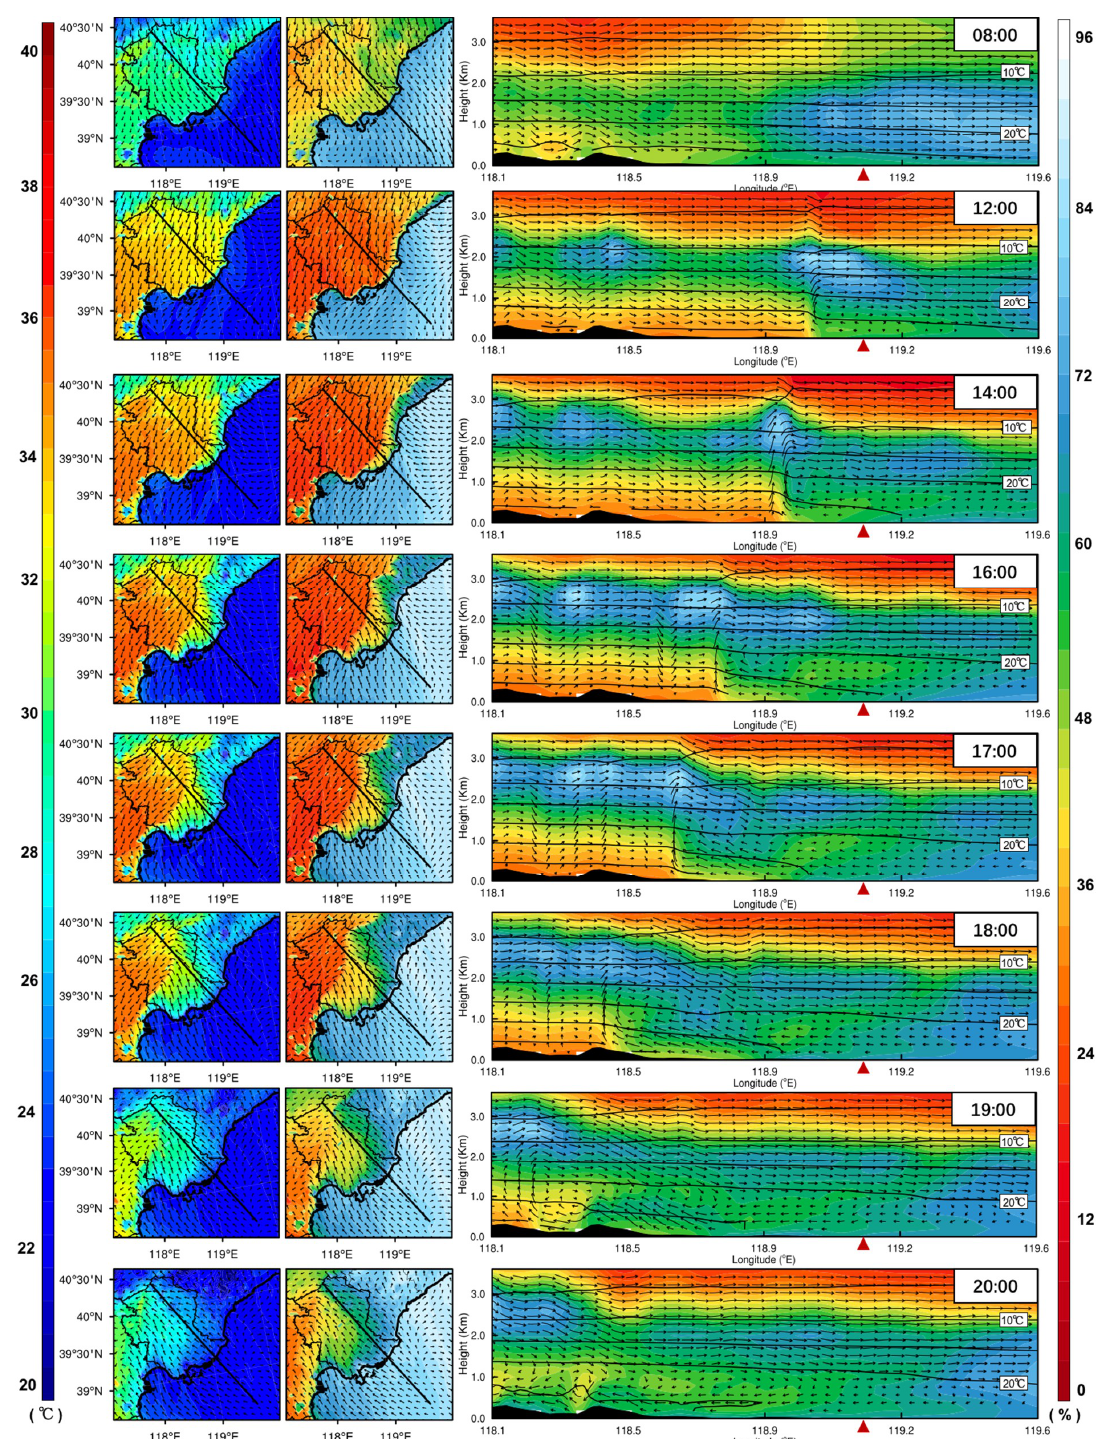
Figure 4. The simulated horizontal evolution of 2-m temperature (T 2 ) (the left column), 2-m relative humidity (RH 2 ) (the middle column) overlaid by the surface wind vectors, and the vertical cross sections of simulated relative humidity (the right column) overlaid by the temperature contours and wind vectors. The location of the cross section is marked by the black lines in the figures in the left and middle columns. The red triangles in the right column indicate the location of the sea–land boundary. Note that the vertical velocity is multiplied by a factor of 20 when plotting the wind vectors.